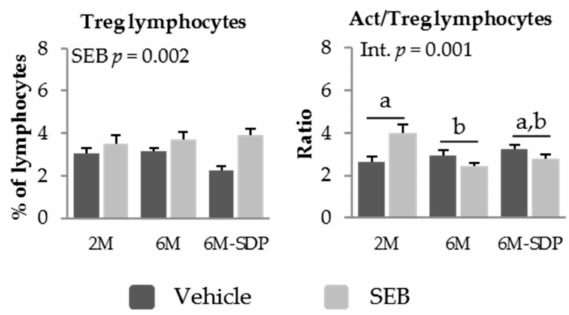
Figure 5. Cell recruitment ( A ); percentage of activated (Act.) Th lymphocytes ( B ); percentage of regulatory (Treg) Th lymphocytes ( C ); and the ratio of activated to regulatory Th lymphocytes ( D ), in mesenteric lymph nodes (MLN) of SAMP8 mice of the 2-month-old (2M), 6-month-old (6M), and 6-month-old fed spray-dried plasma (6M-SDP). The dark grey bars represent groups that received the vehicle and the light grey bars represent mice administered with S. aureus enterotoxin B (SEB). Results are expressed as means ± SEM ( n = 5–8 animals). Means without a common letter differ, p < 0.05. Int., interaction between factors (SEB administration and experimental groups; 2M, 6M,